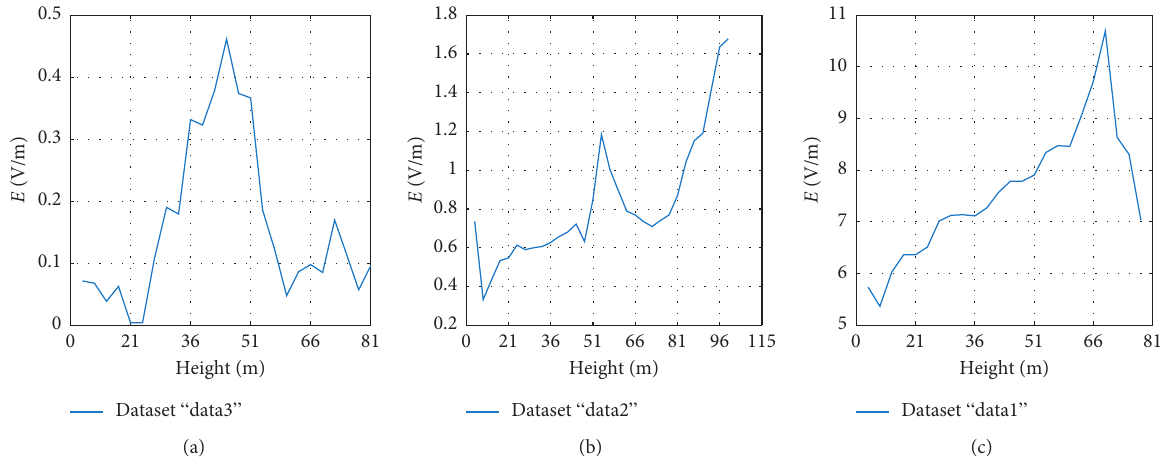
Figure 2: Graph for original (a) “data3” dataset; (b) “data2” dataset; (c) “data1” dataset.